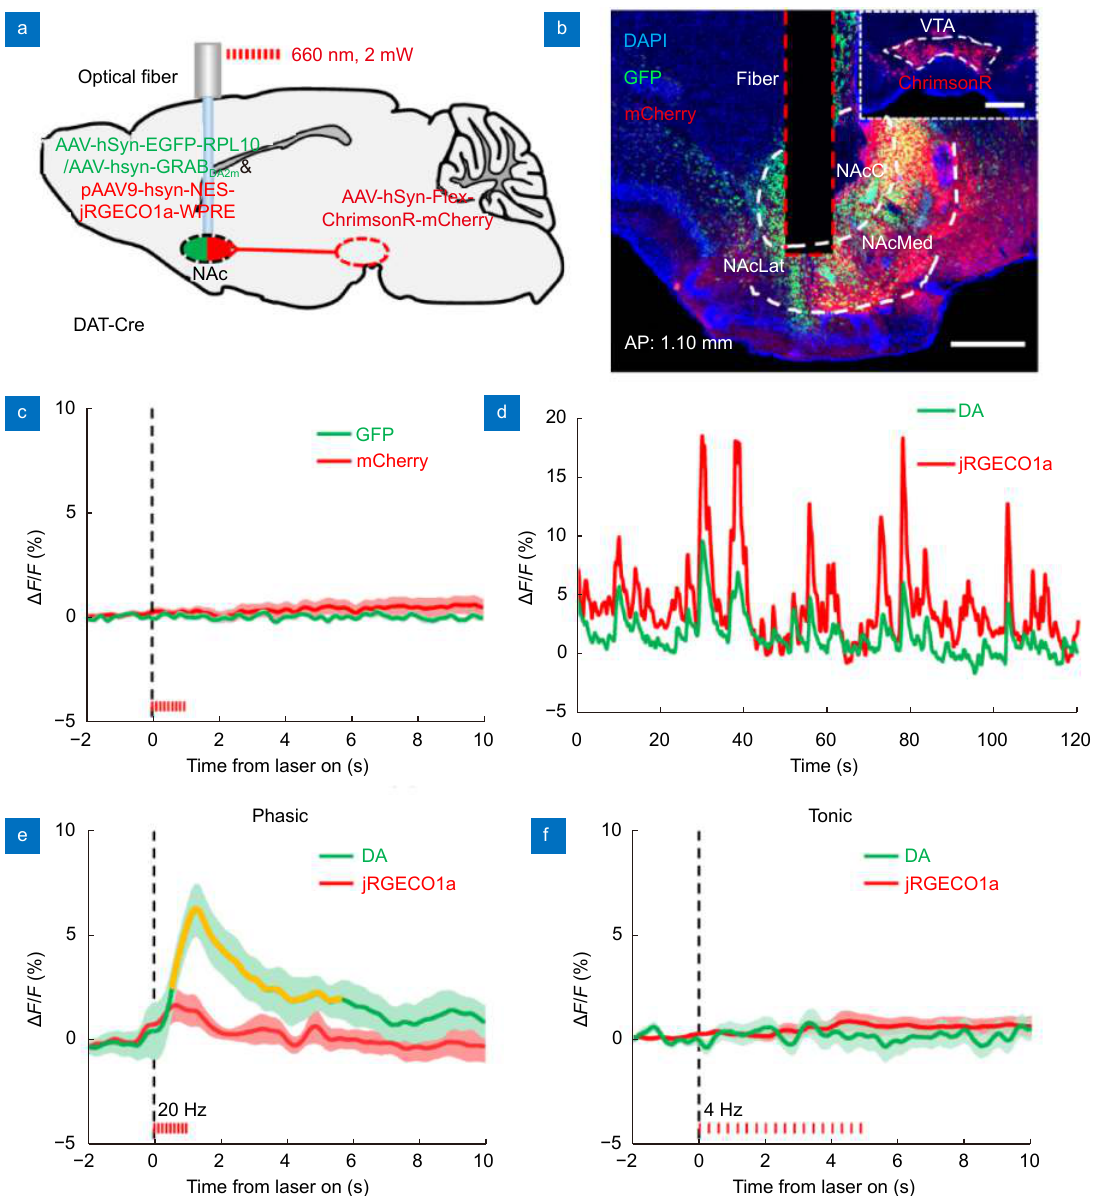
Fig. 6 | Simultaneous dual-color recording and optogenetic manipulation of neuronal activities in the NAcLat of a freely moving mouse. ( a ) Schematic diagram of simultaneous dual-color recording and optogenetic manipulation of neuronal activity surgery: we record GFP and mCh- erry fluorescence simultaneously, while specifically activating the terminals of VTA-NAc dopaminergic neurons (ChrimsonR: Ex 660 nm) in the NAcLat of a freely moving mouse. Note that GFP was replaced with GRAB DA2m and jGRECO1a in subsequent experiments. ( b ) Histology con- firming GFP (green) labeled neurons and ChrimsonR (red) labeled dopaminergic neuron terminal expression in the NAcLat. The brain slice is 1.1 mm anterior to the bregma. Scale bar, 500 μm. ( c ) No stimulation artifacts exist when simultaneously performing optogenetic manipulation and real-time dual-color recording in this system. The red bar indicates the time of stimulation. ( P >0.05, Wilcoxon’s signed-rank test; n = 20 pairs, one mouse). ( d ) Example of DA and neuronal Ca 2+ traces simultaneously recorded in the NAcLat of a freely moving mouse. ( e ) Averaged DA signal and neuronal Ca 2+ signal transients in response to phasic optogenetic stimulation (10 trials). The red bar indicates the time of stimulation. The pulse duration is set to 20 ms at 20 Hz, and lasts for 1 s in each trial. Orange segments indicate a statistically significant increase from the baseline (* P <0.05, Wilcoxon’s signed-rank test; n = 10 pairs, one mouse). ( f ) Averaged DA signal and neuronal Ca 2+ signal transients in re- sponse to tonic optogenetic. The red bar indicates the time of stimulation. The pulse duration is set to 10 ms at 4 Hz, and lasts for 5 s in each tri- al. No significant fluorescence changes are detected in the DA signals or the neuronal Ca 2+ signals. ( P >0.05, Wilcoxon’s signed-rank test; n = 10 pairs, one mouse). Abbreviations: DA, dopamine; NAc, nucleus accumbens; NAcC, nucleus accumbens core; NAcLat, nucleus accumbens later- al shell; NAcMed, nucleus accumbens medial